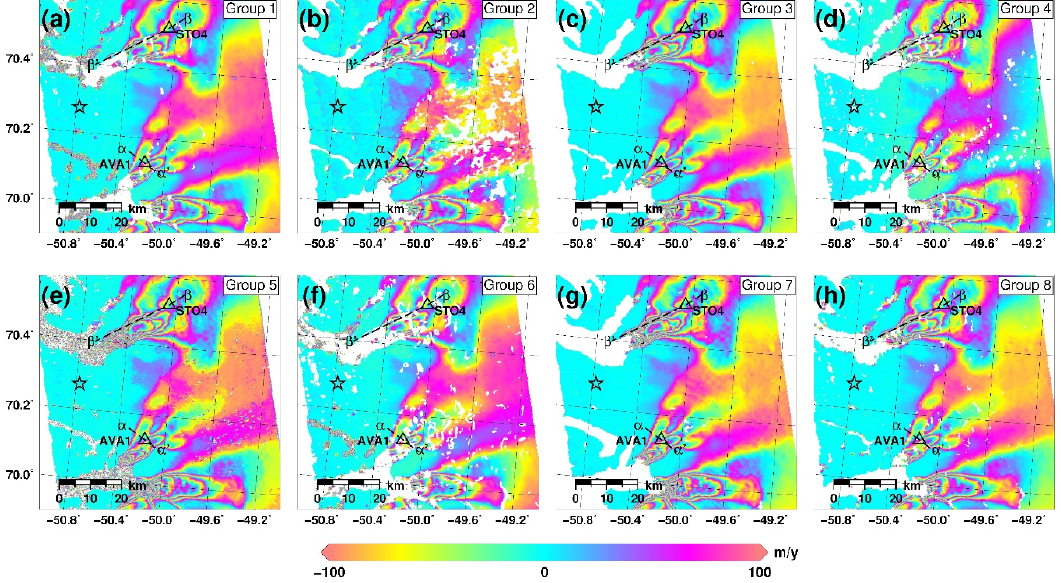
Figure 20. Task 4 wrapped LoS velocity maps provided by groups 1 to 8 ( a – h ) in the area of GPS stations STO4 and AVA1. Each color cycle represents a 200 m/y variation. Velocities are referred to the star (zero velocity).